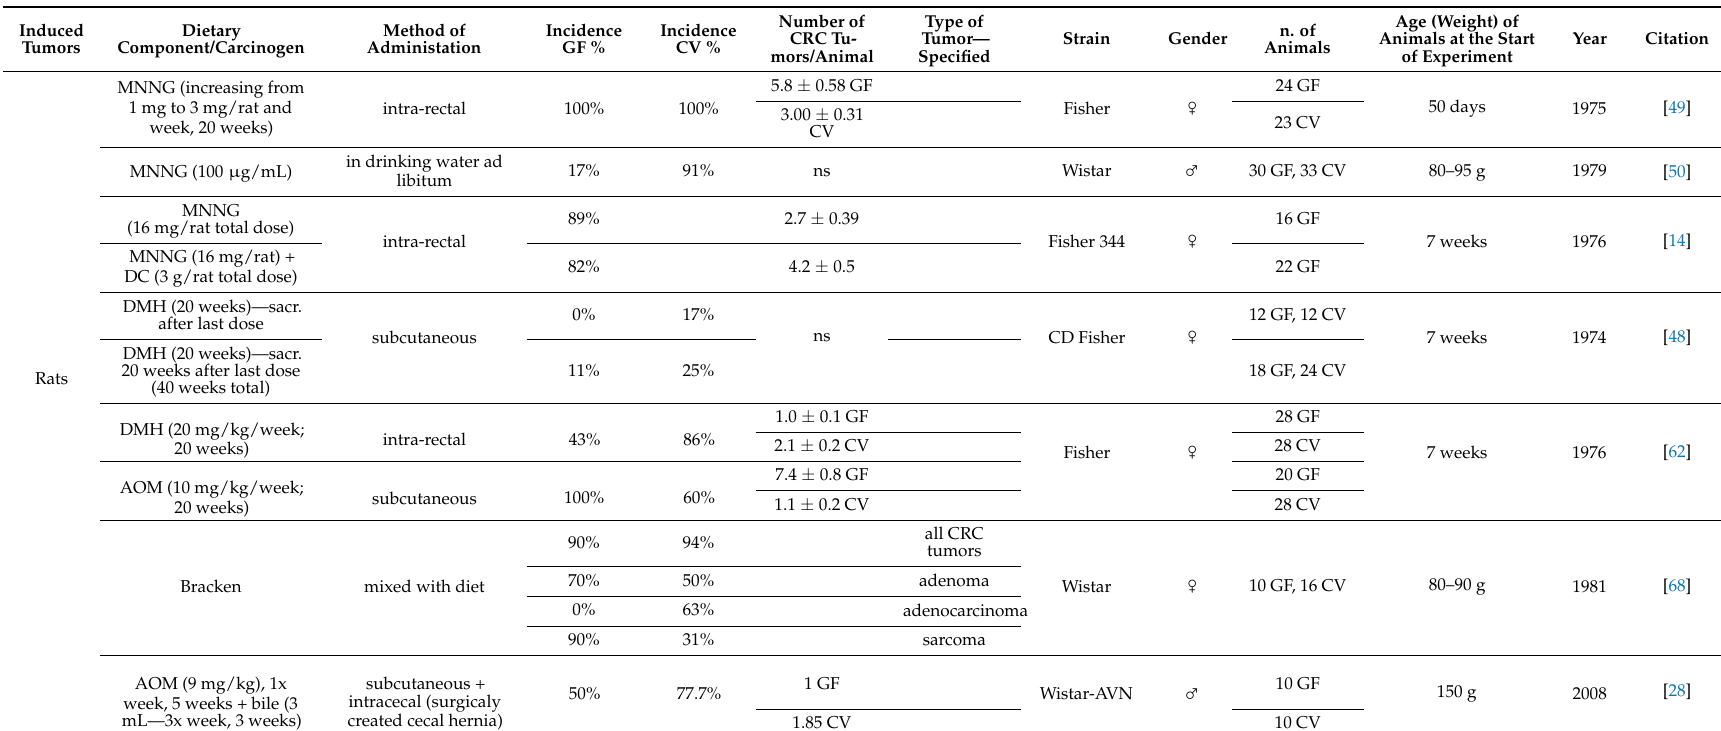
Table 4. Colorectal cancer induction by carcinogens in GF rats and